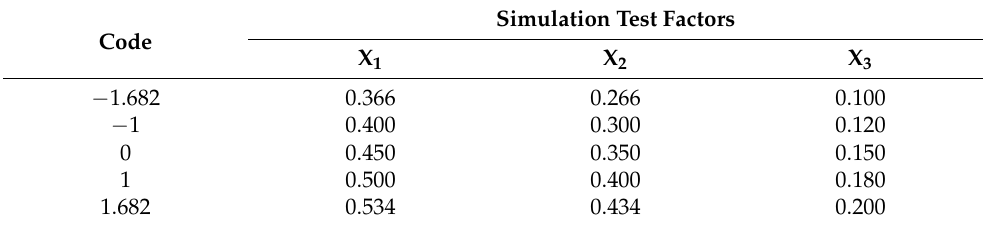
Table 7. Experiment factors and